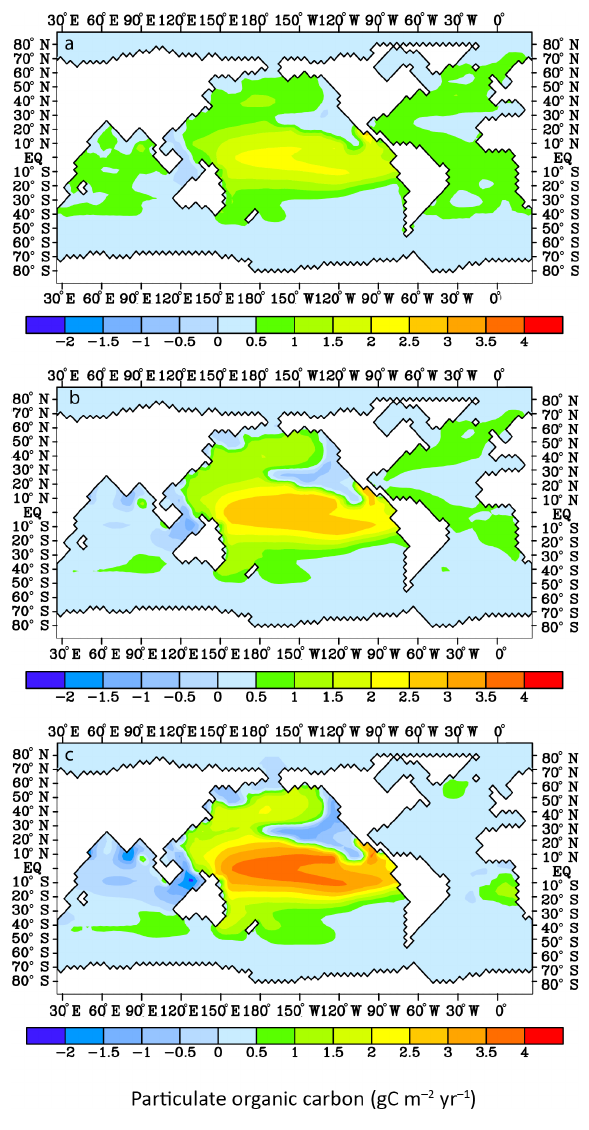
Figure 2. The difference in particulate organic carbon (µmolkg − 1 ) for (a) 4 × CO 2 and the reference simulation, (b) 6 × CO 2 and the reference simulation, and (c) 8 × CO 2 simulation and the reference